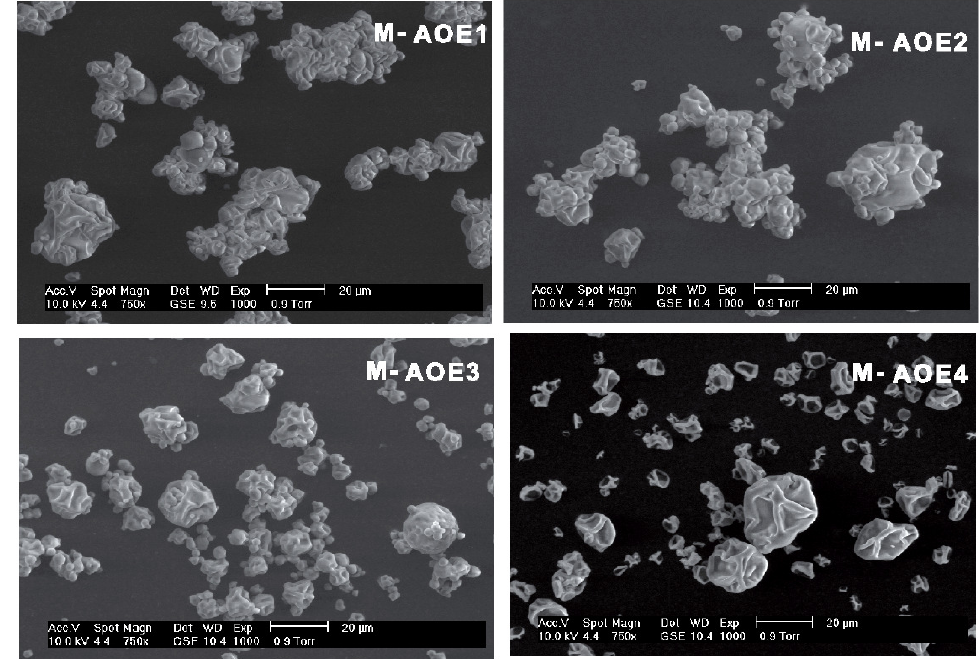
Figure 4. Microstructure of spray dried microparticles from avocado oil-in-water emulsions observed by SEM (at 750 × magnification). M-AOE1, M-AOE2, and M-AOE3 contain phosphorylated starch, Gum Arabic, and HI-CAP ® 100 starch. Sample M-AOE4 contains phosphorylated starch and HI- CAP ® 100